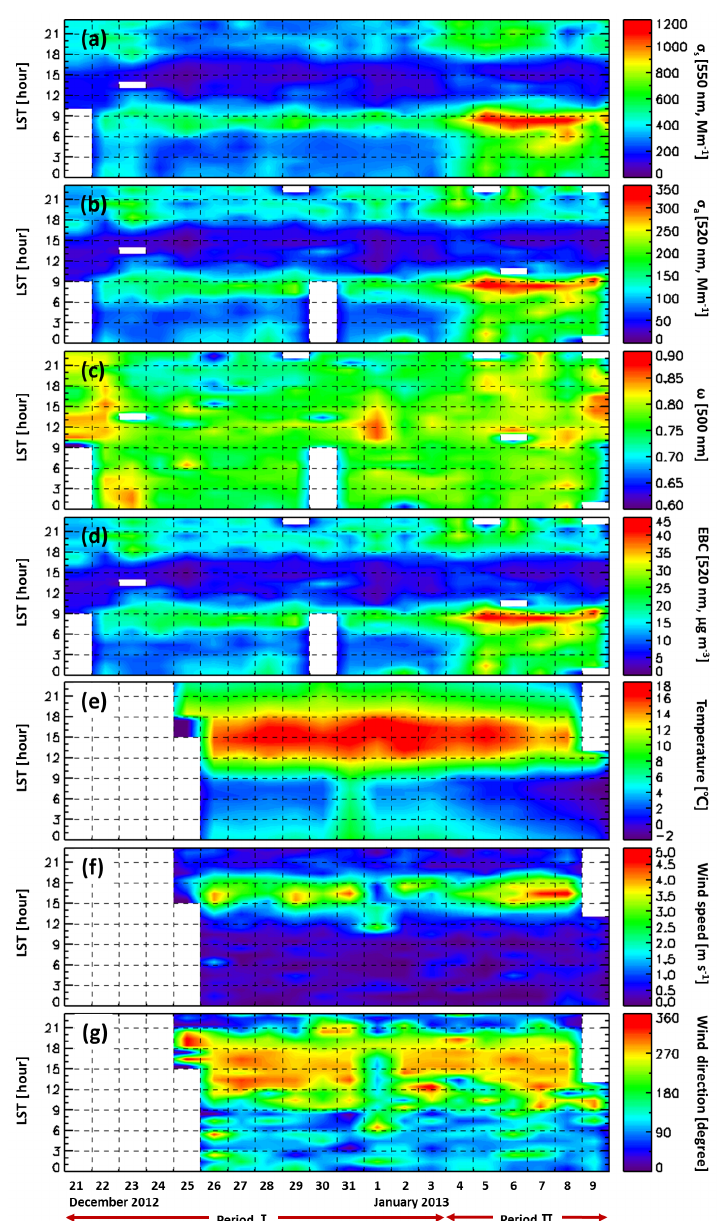
Figure 3. Hourly variation in the (a) aerosol scattering coefficient, (b) aerosol absorption coefficient, (c) single scattering albedo, (d) EBC mass concentration, (e) ambient temperature, (f) wind speed, and (g) wind direction at the Bode site in the Kathmandu Valley over the